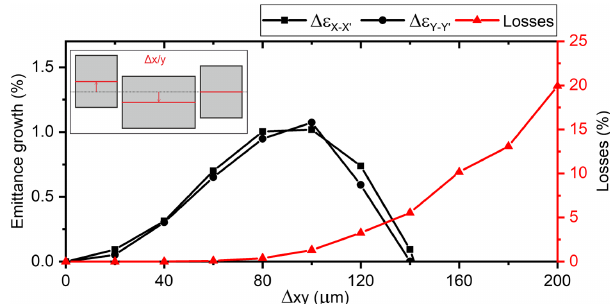
FIG. 25. Transverse beam envelopes along the linac.